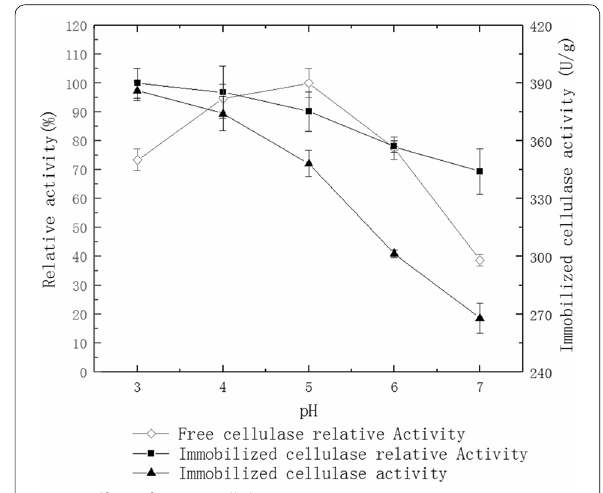
Fig. 4 Effect of pH on cellulase